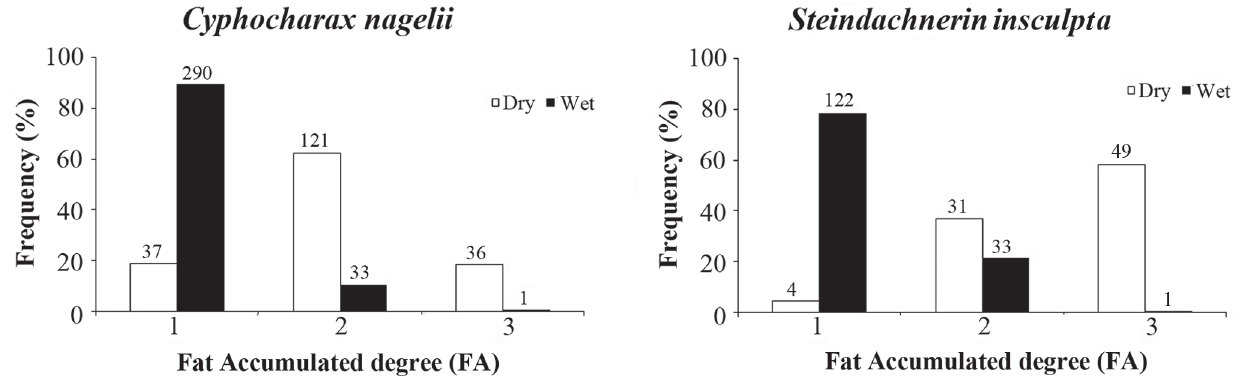
Fig. 2. Fat accumulated degree (FA) of Curimatidae species during dry and wet seasons. 1: no fat, 2: visceral cavity partially filled with fat, and 3: visceral cavity completely filled with fat. Values above bars represent the absolute numbers of fat accumulated degrees obtained in each period.